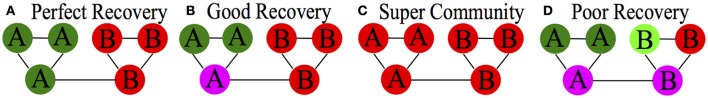
Conceptual depiction of types of accuracy. (A) “Perfect Recovery” refers to all nodes being placed in the correct community; (B) “Good Recovery” reflects nodes being placed in the correct community most of the time; (C) “Super Community” indicates a phenomenon where nodes are subsumed into one large community; (D) “Poor Recovery” is when nodes are simply placed in communities with other nodes erroneously. (A) indicates ARIHA of 1.00; (B) would have < 1.00; (C,D) would be closer to 0.00.